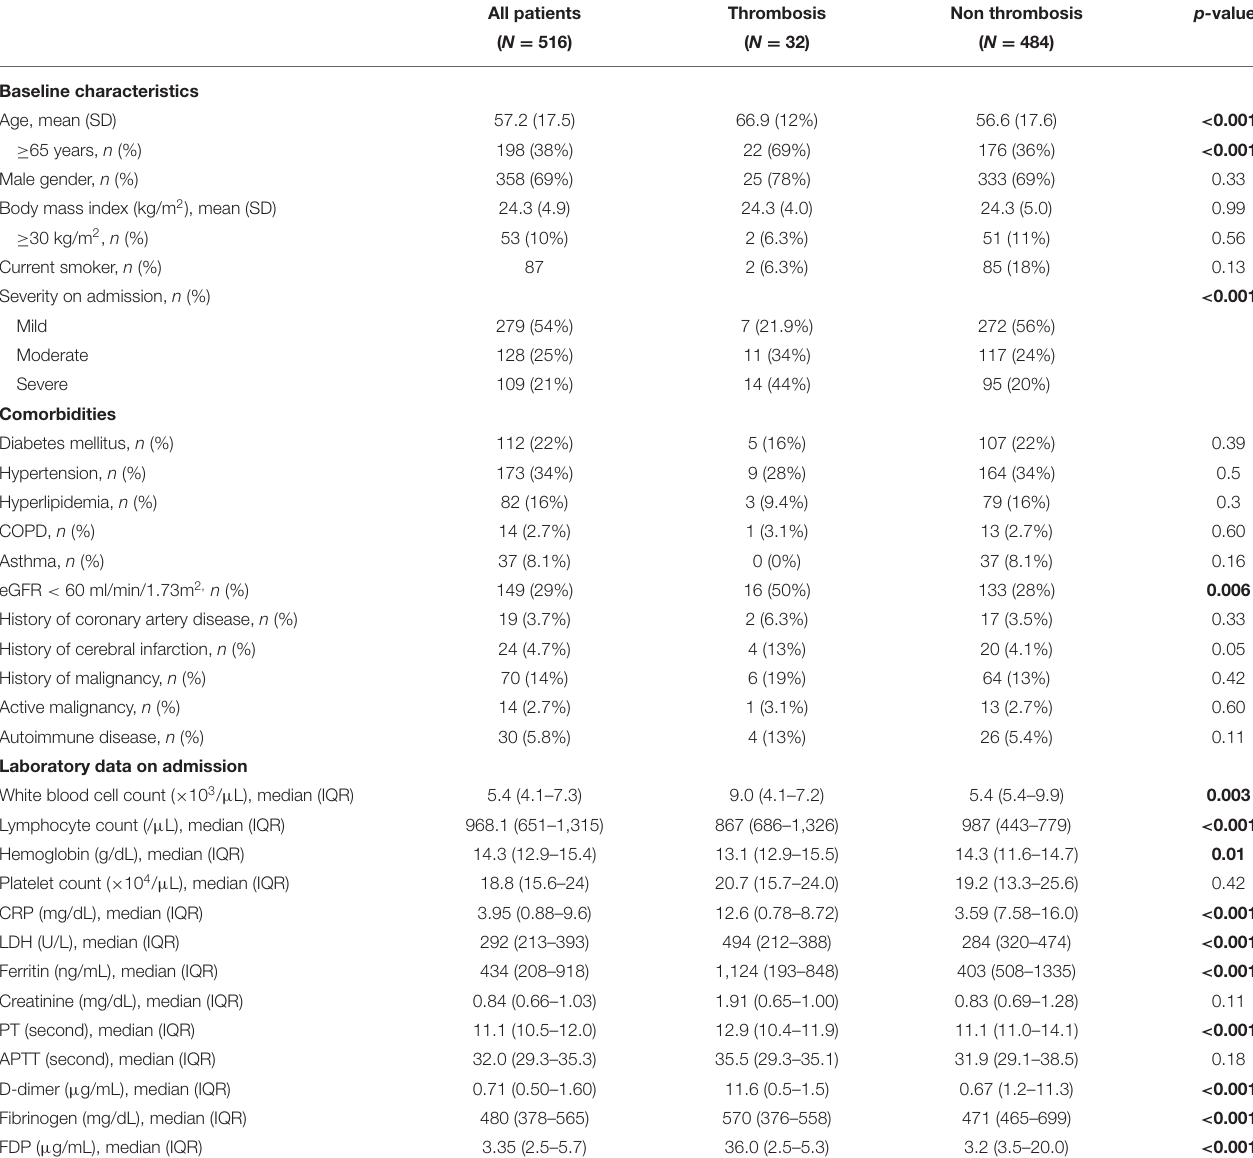
TABLE 1 | Clinical characteristics of the patients complicated with or without thrombosis in the cohort. All patients Thrombosis Non